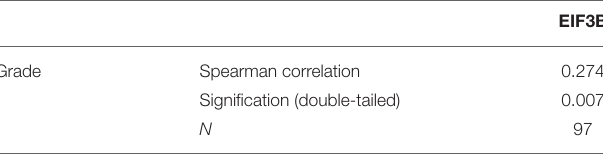
TABLE 3 | Relationship between EIF3B expression and tumor grade in patients with pancreatic